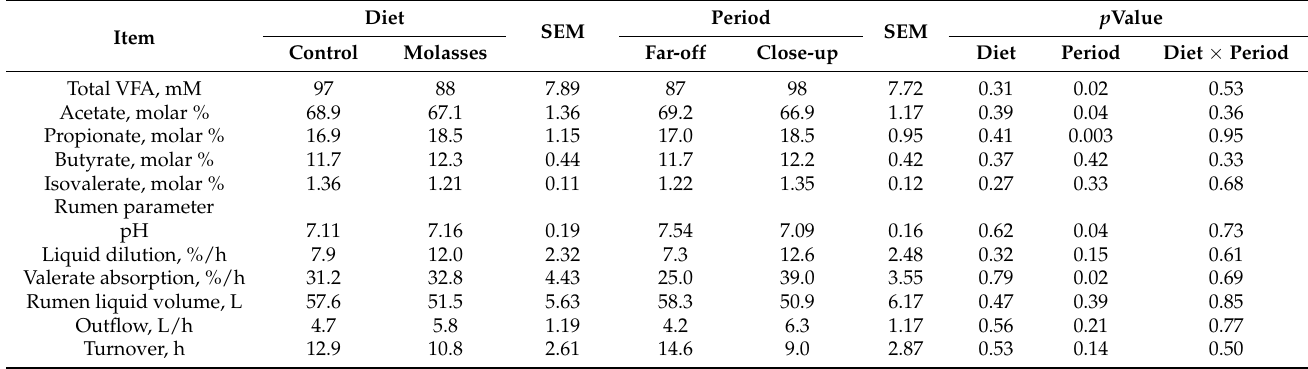
Table 11. Rumen fluid volatile fatty acids (VFA) proportions, pH, and kinetics during the prepartum period for cows fed either control or molasses-containing diets during a 60-day dry period (Experiment 2).